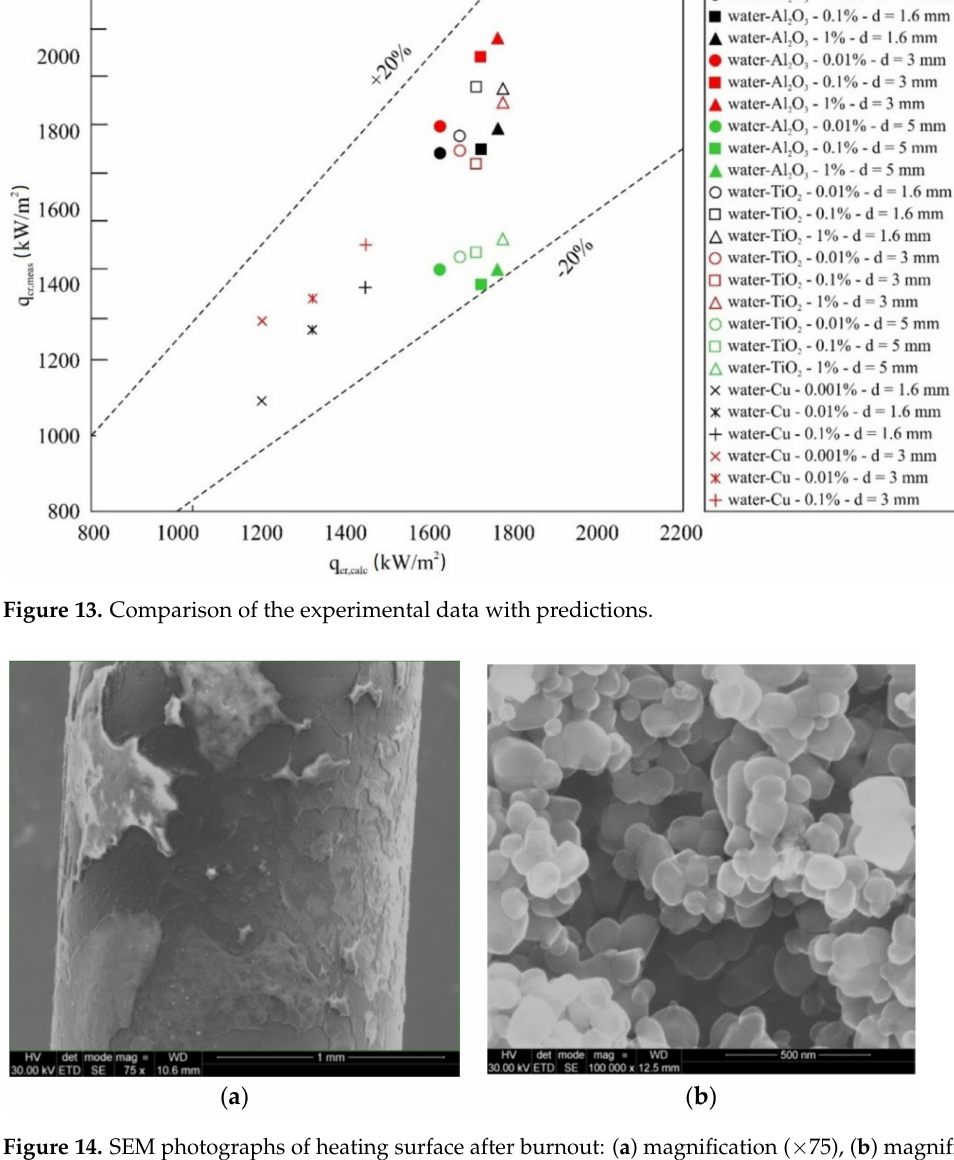
Figure 14. SEM photographs of heating surface after burnout: ( a ) magnification ( × 75), ( b ) magnifica- tion ( ×